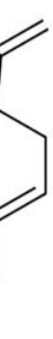
Table 5. Main components of A. leucotrichus essential oils in literature and their extraction yields.